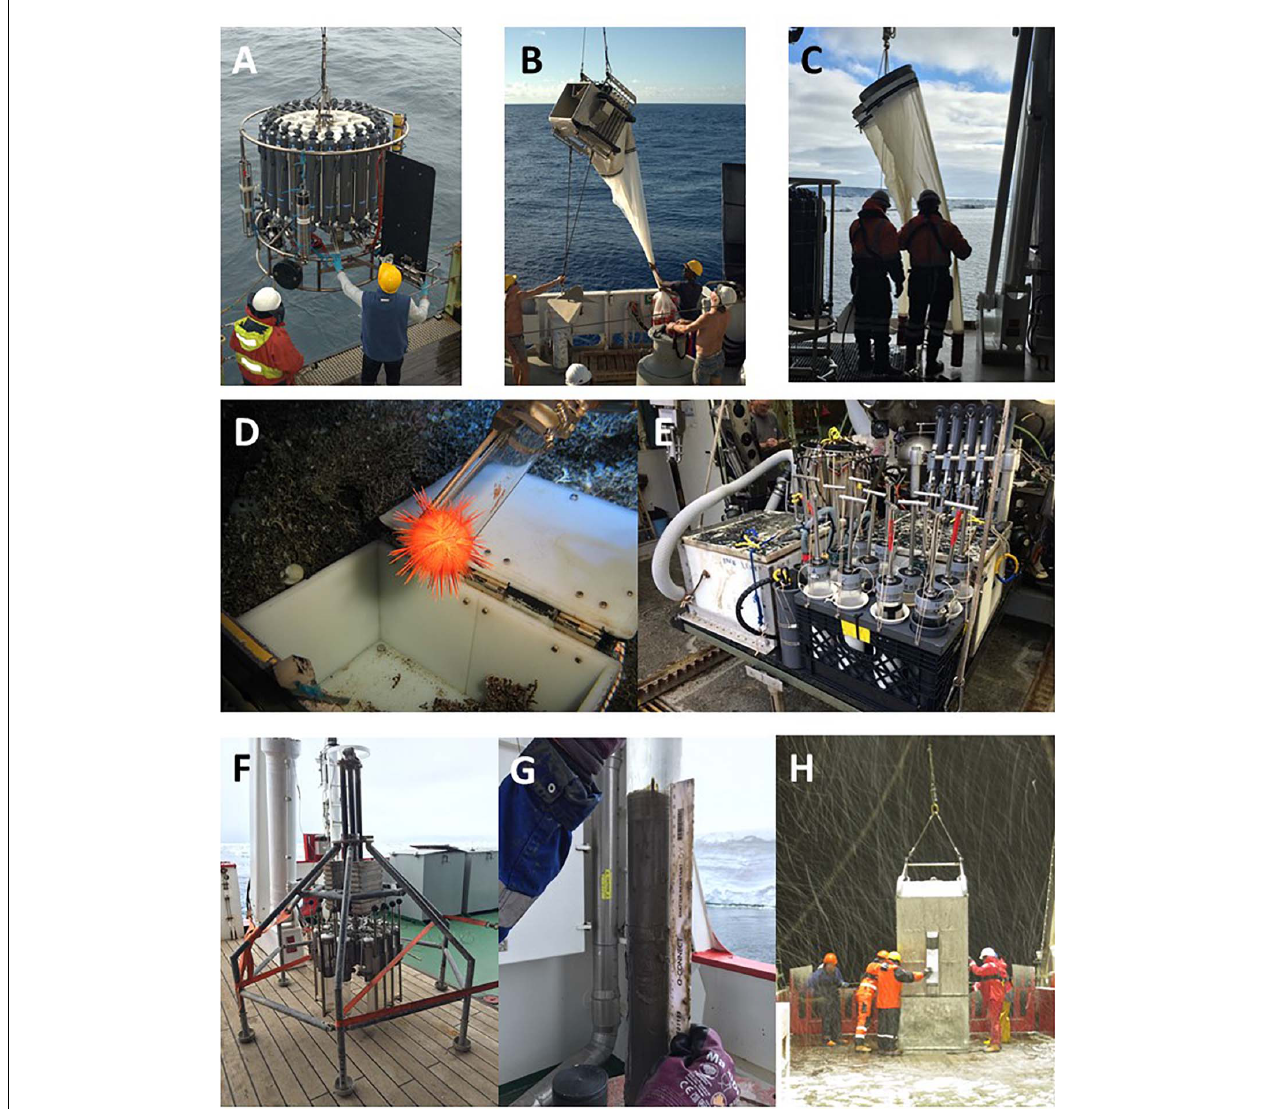
FIGURE 2 | Sampling equipment for marine scientific research. (A) Water sampling rosette with Conductivity, Temperature, and Depth (CTD) sensors for collecting water samples for physical oceanographic measurements, biogeochemistry, and microbiology (A. D. Rogers). (B) Macrozooplankton trawl (A. D. Rogers); a multiple net system which collects samples of small zooplankton. (C) Bongo net for taking vertically hauled samples of plankton (M. L. Taylor). (D) Specimen of the urchin Dermechinus horridus being sampled using an ROV “slurp gun” (A. D. Rogers). (E) Science skid of the submersible Alvin showing push cores and biobox for samples (L. Levin). (F) Multicorer for deployment over the side of a research vessel (M. L. Taylor). (G) Core tube with sample of sediment (M. L. Taylor). (H) Epibenthic sledge, a type of trawl used to take samples of megafauna from the seafloor (M. L.